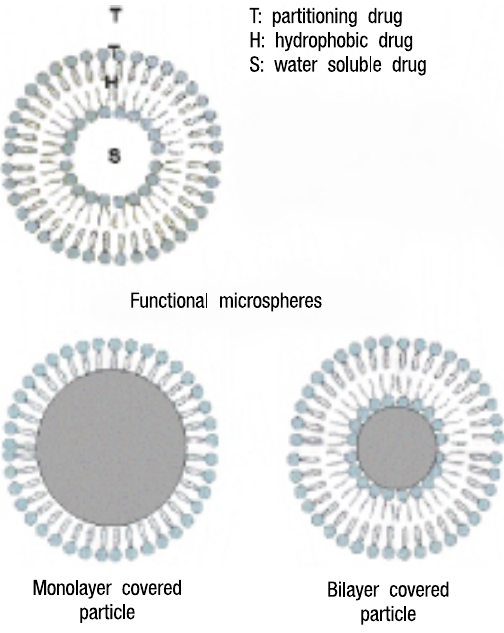
Fig. 1 – Bilayer vesicles and liposomes as drug carriers or as sources of organized supramolecular assemblies to cover solid